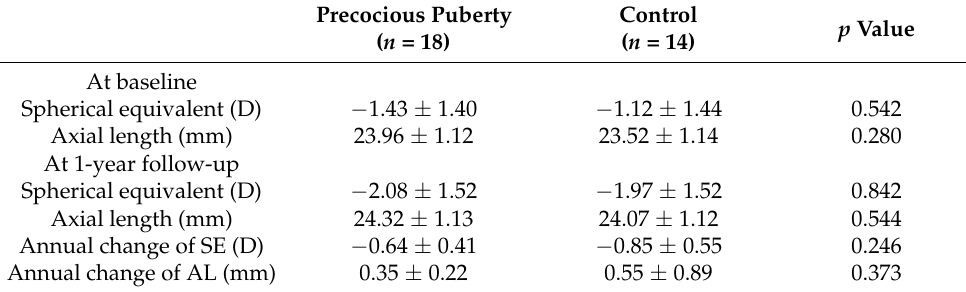
Table 2. Myopic progression over 1 year.